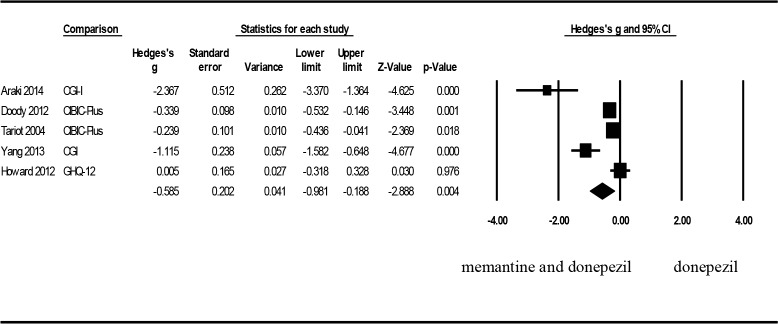
Forest plots to compare the combination therapy with the monotherapy: global functions.